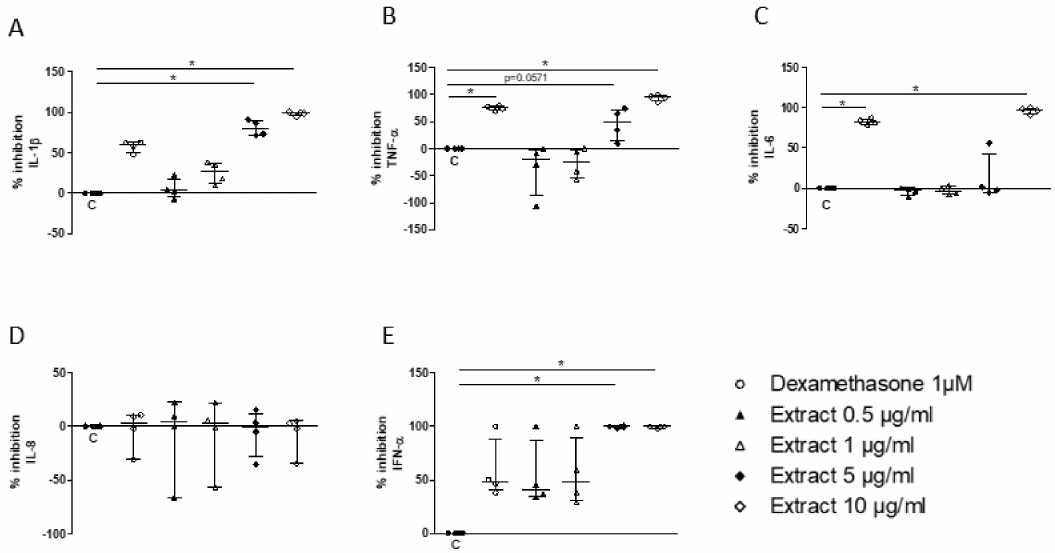
Figure 4. Inhibitory effect of S. miltiorrhiza extract (0.5, 1, 5, and 10 µ g/mL) on PBMC release of IL-1 β ( A ), TNF- α ( B ), IL-6 ( C ), IL-8 ( D ), and IFN- α ( E ) upon stimulation by R848 (1 µ g/mL). Data are median ± interquartile range ( n = 5; * p <